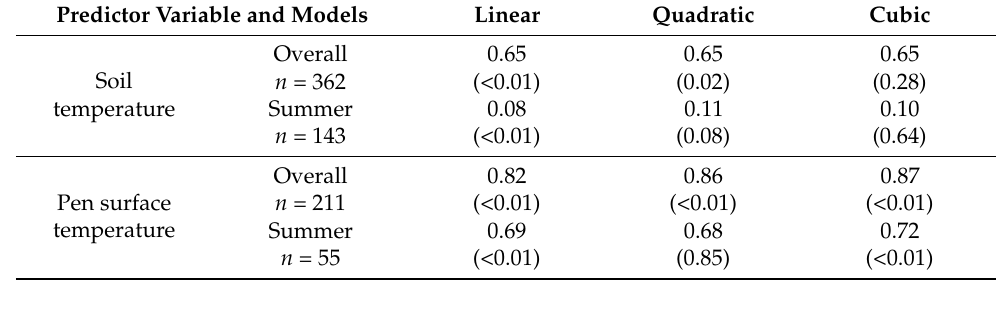
Table 1. Adjusted coefficients of determination ( p -values) for models’ prediction of daily water intake (DWI) using soil temperature and pen surface temperature.